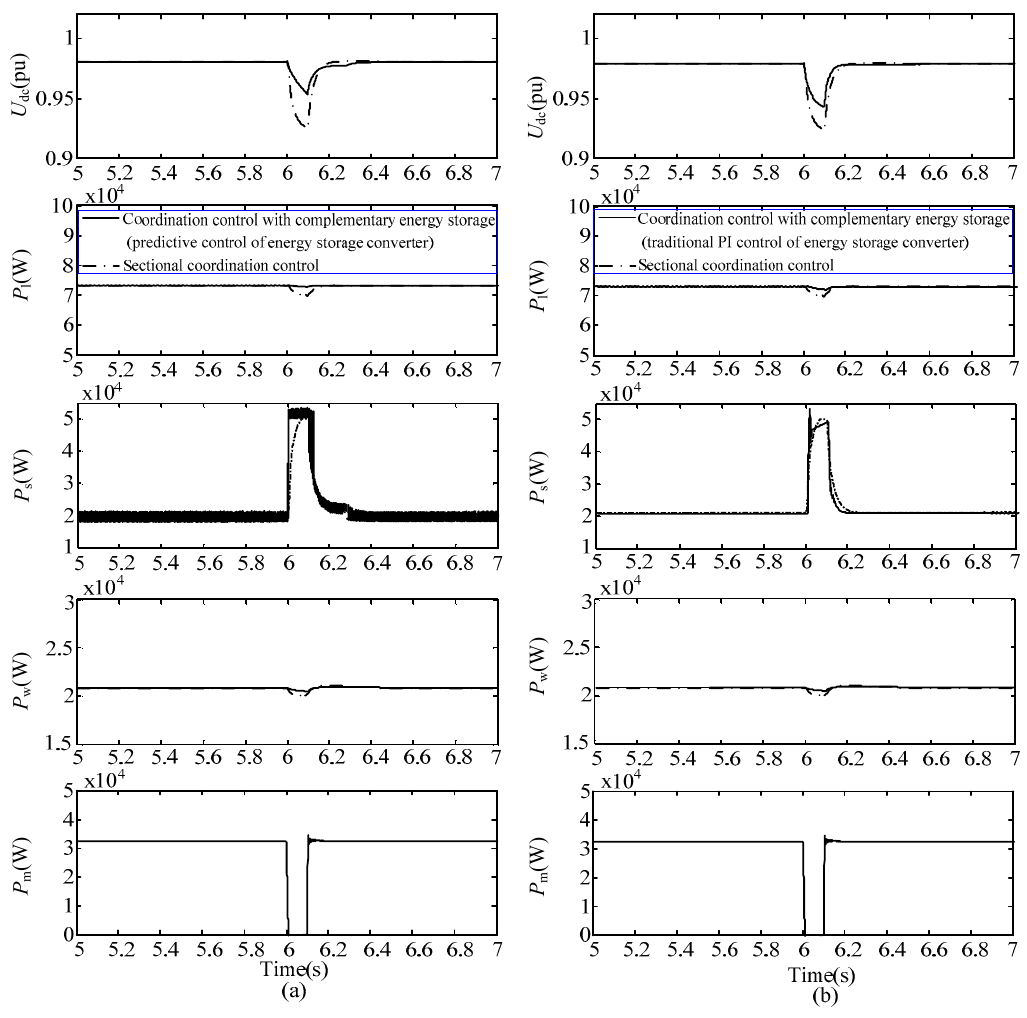
Figure 13. Performance of each unit in the DC microgrid under fault condition in the biomass unit: ( a ) The solid lines were obtained by using the improved method of hybrid complementary energy storage based on prediction and the dotted lines were obtained utilizing the basic coordinated control; ( b ) The solid lines were obtained by using the improved method based on PI control and the dotted lines were obtained utilizing the basic coordinated control.